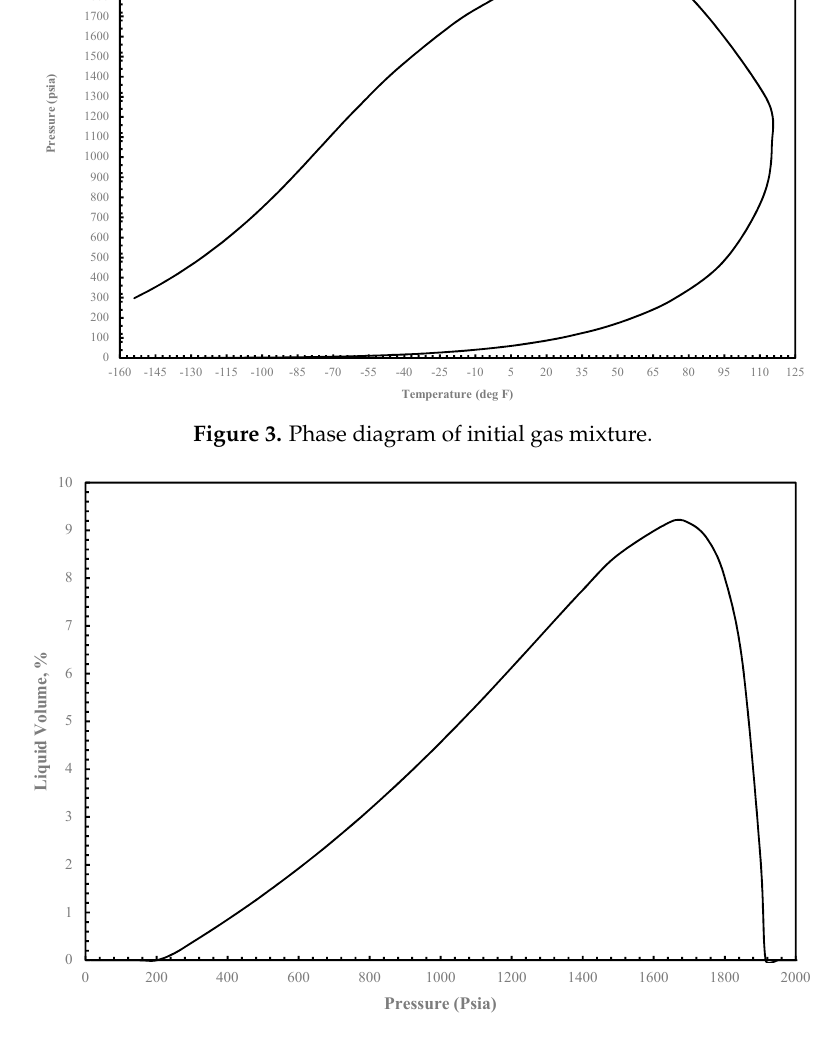
Figure 4. Liquid dropout curve of methane and n -butane gas condensate mixture, 20 °C (68 °F).